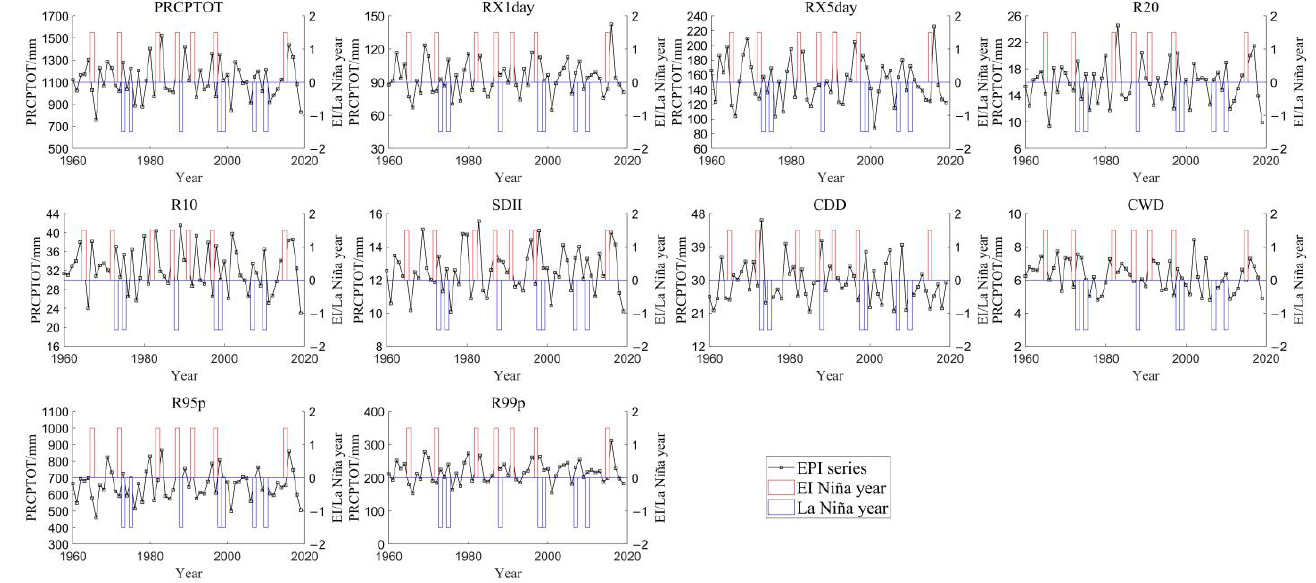
Figure 12. The annual EPIs and El Niño and La Niña years from 1960 to 2019 in Hubei province.